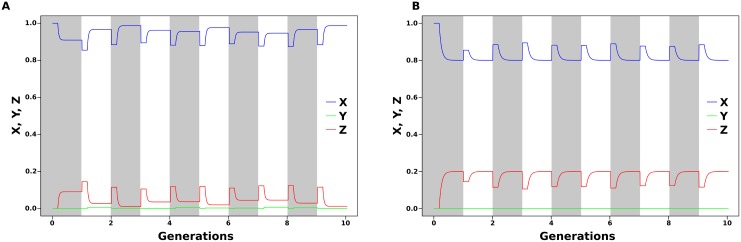
The effect of random changes in α and δ across generations in one sex (A, female) does not affect the final methylation level of the adults in the other sex (B, male).Plot shows 10 generations (shades of grey) of 250 cell divisions each.